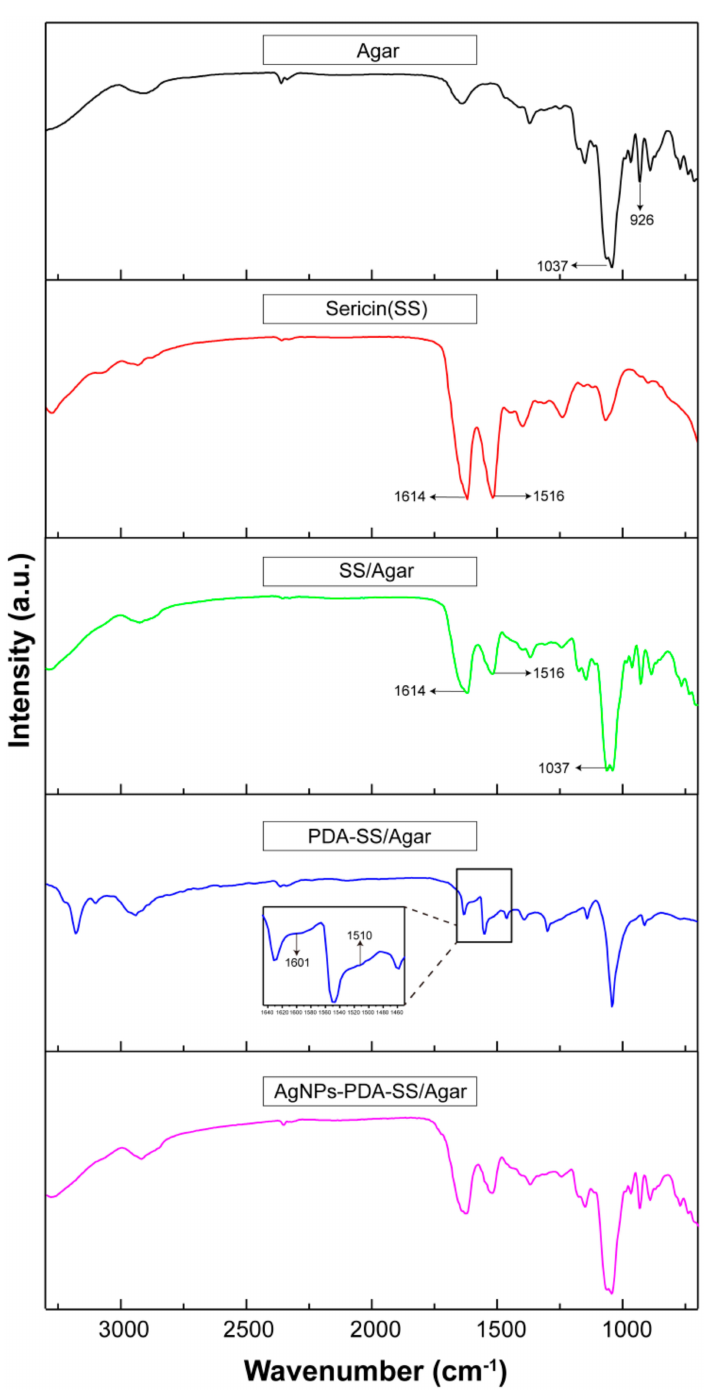
Figure 3. FT-IR spectra of Agar, Sericin (SS), SS/Agar, PDA-SS/Agar and AgNPs-PDA-SS/Agar